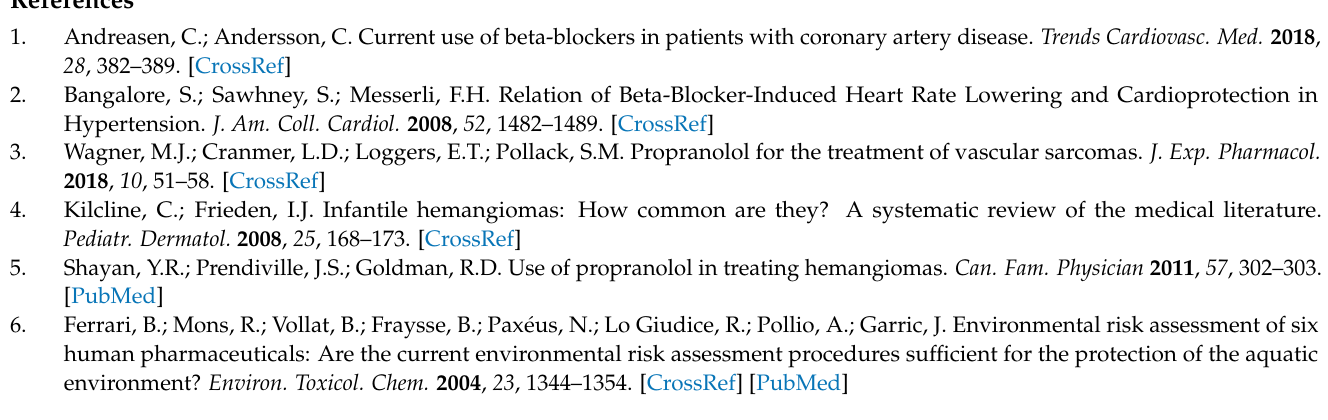
with contact time of 0.1 ms showing directly bonded C–H links only. Figure S7. PXRD pattern of PRO, CAP, PRC, EUT1 and EUT2. The PXRD pattern of EUT1 consists of peaks corresponding to PRC and CAP only, while the PXRD pattern of EUT2 consists of peaks corresponding to PRC and PRO only. Figure S8. Thermogravimetric analysis (TGA) data for PRO, CAP, PRC, EUT1 and EUT2. Figure S9. PXRD pattern of PRO, CAP, PRC and the physical mixture of PRO and CAP at 0.4 mol fraction of PRO. The PXRD pattern of the sample comprising 0.4 mol fraction of PRO consists of peaks of the starting materials or salt only. Figure S10. Temperature/composition phase diagram for the PRO-CAP system based on data published by Stott et al. [1], obtained from Elsevier with permission. Figure S11. Theoretical prediction of temperature and composition of the eutectic formed between PRO and CAP. The theoretical liquidus curves were calculated using the Schroeder van Laar equation. Using this equation, it was found that the calculated eutectic melting temperature is around 30.5 ◦ C and this eutectic phase would comprise 0.055 mol of PRO. Figure S12. DSC thermograms of CAP (analysed as received), PRC (crystallised from ethanol) and samples prepared by co-grinding PRO and CAP in an agate mortar at 0.2 mol fraction of PRO at 4 ◦ C. Figure S13. (a) DSC traces of the CAP-PRC physical mixtures from the first heating cycle; (b) DSC traces of the PRO-PRC physical mixtures from the first heating cycle; (c) DSC 2nd heating cycle thermograms of CAP-PRC systems and (d) DSC 2nd heating cycle thermograms of PRO-PRC systems. The labels represent the mol fraction of PRO. Figure S14. Relaxation map of EUT2. The solid line denotes VFT fit of experimental